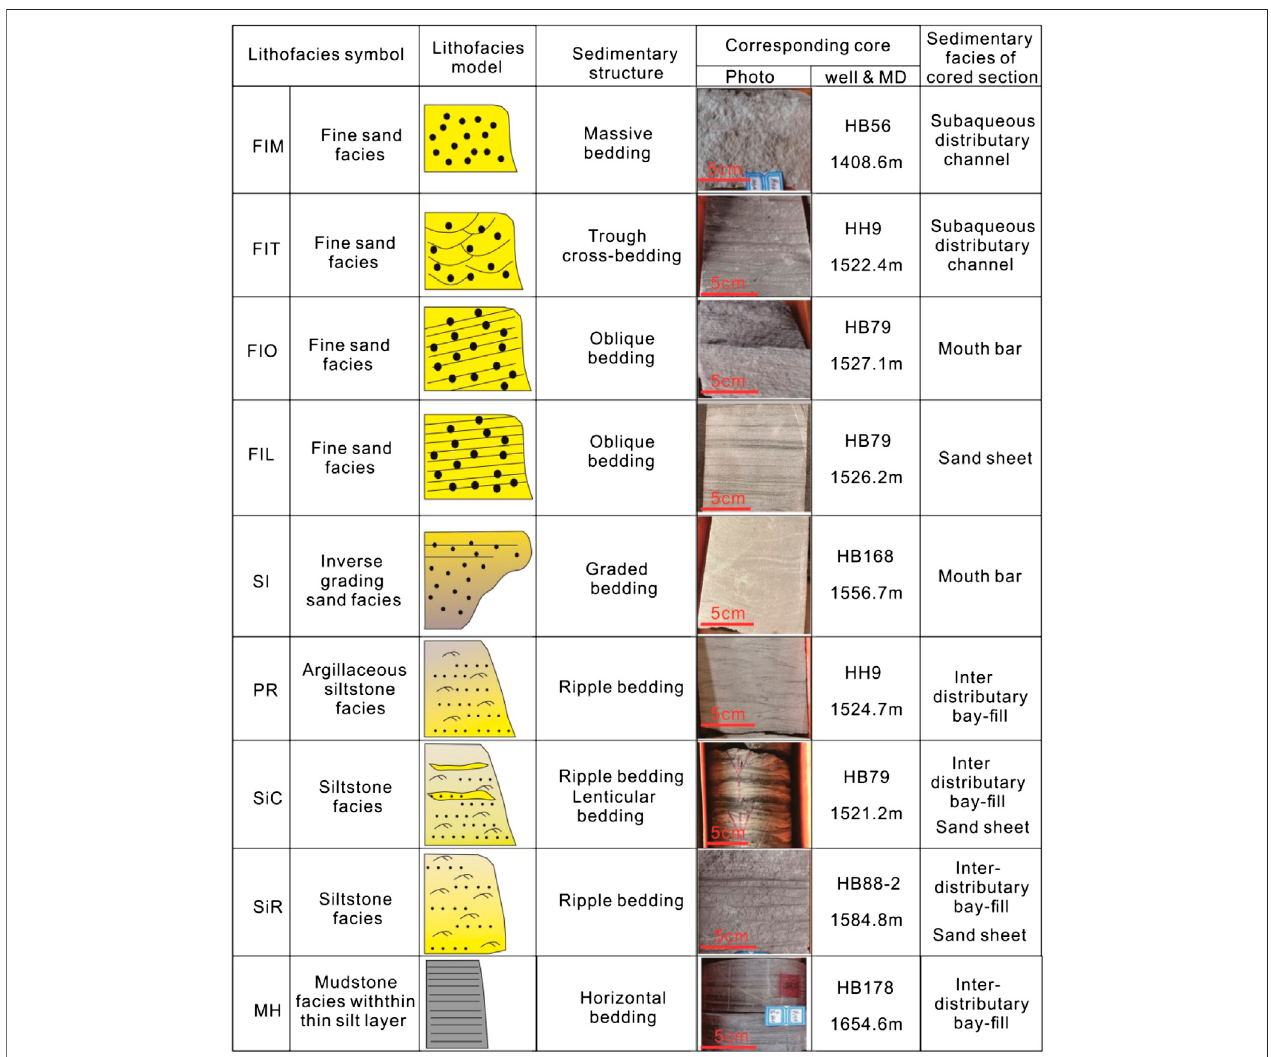
FIGURE 6 | Nine single lithofacies types and their corresponding relations with sedimentary structures and facies.